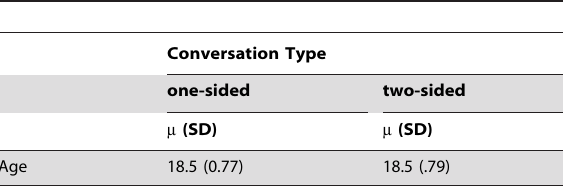
Table 4. Average age for participants in the one-sided and two-sided conditions.